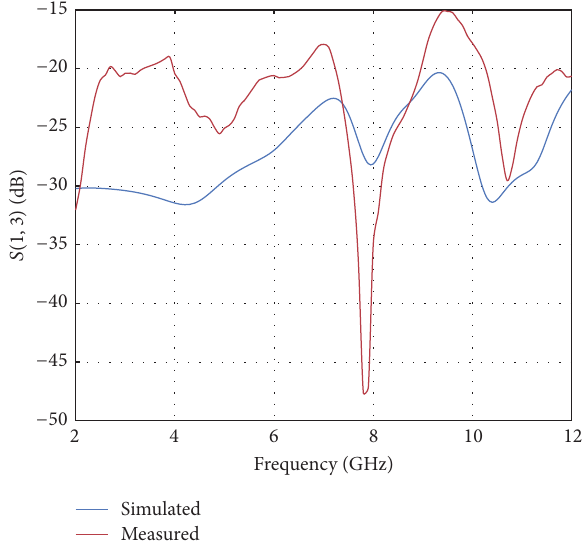
Figure 25: Comparison of simulated and measured transmission coefficients between the UWB and the second NB antenna